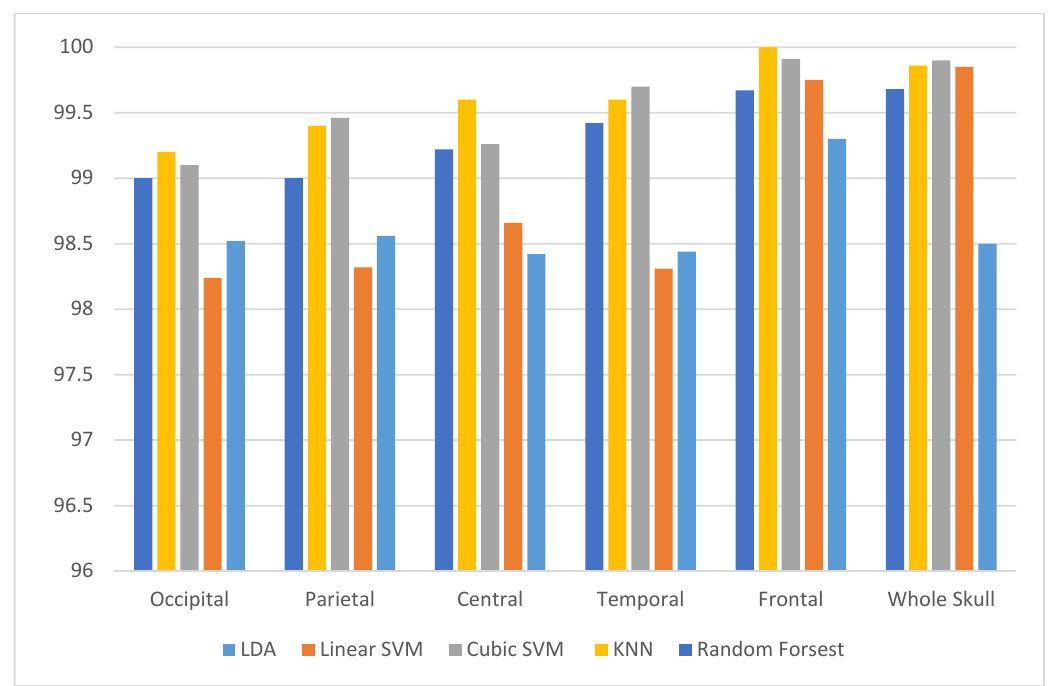
Figure 10. A comparison between classification accuracies of several classifiers constructed using the proposed Feature-Set 3 extracted from different sites on the skull to detect stress and non-stress states. Table 5. Accuracy (95% CI) for detecting stress and non-stress from different electrode sites .